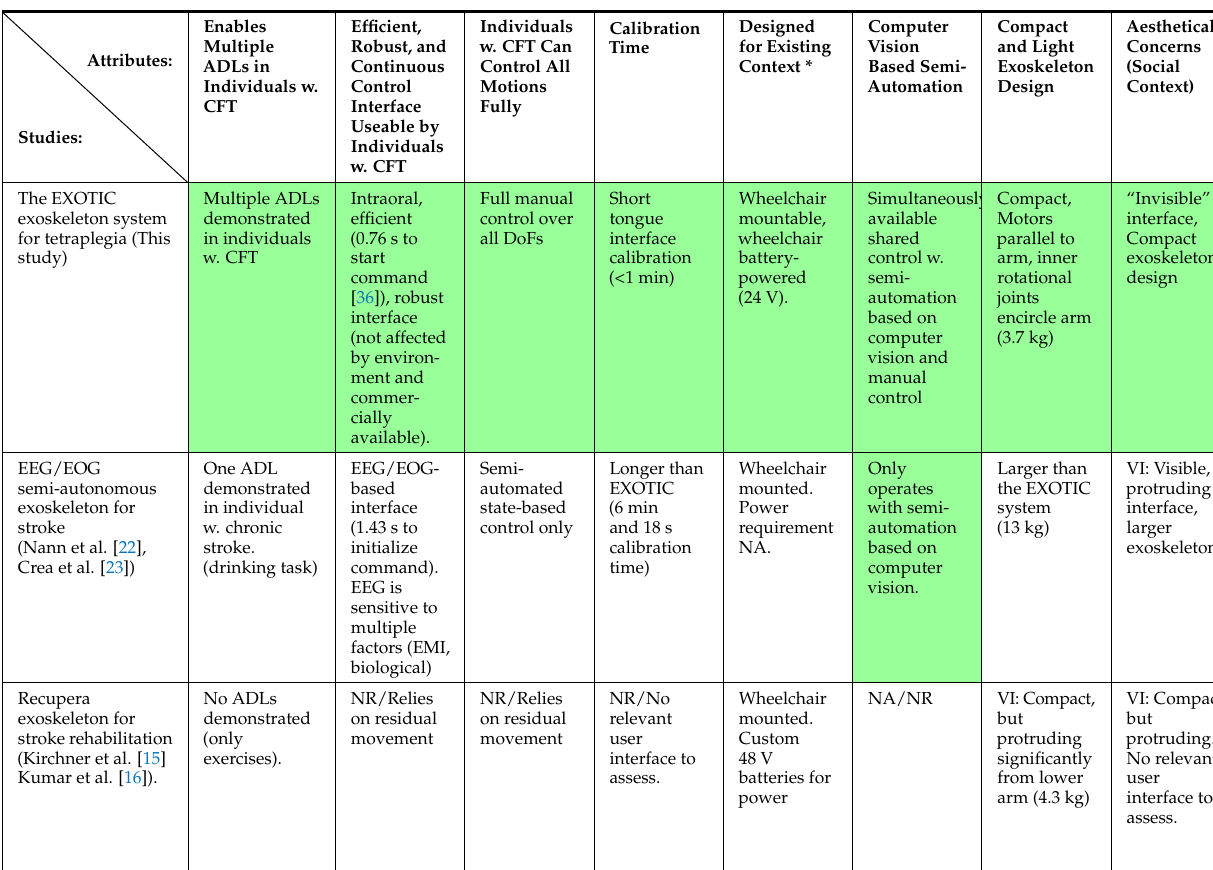
Table 1. An overview of existing exoskeletons and which attributes they fulfill/include. Green shading indicates that the given attribute was fulfilled/included. Selection criteria: (1) must fully support a paralyzed arm, (2) must implement arm (min. shoulder and elbow) actuation and hand (grab) actuation, (3) must